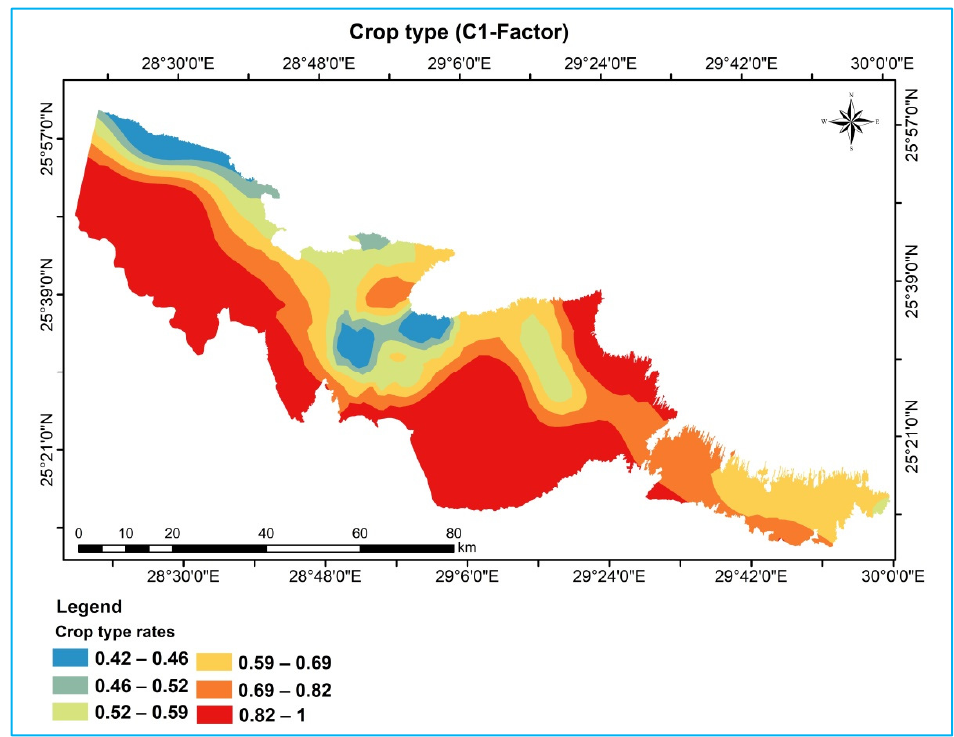
Figure 9. Spatial distribution map of the crop-type factor (C1-Factor).